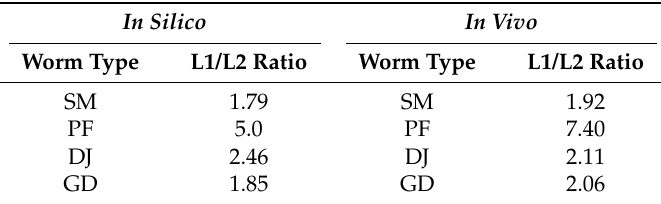
Table 2. Morphometric comparison between computational model outcomes and real head shape measurements in 4